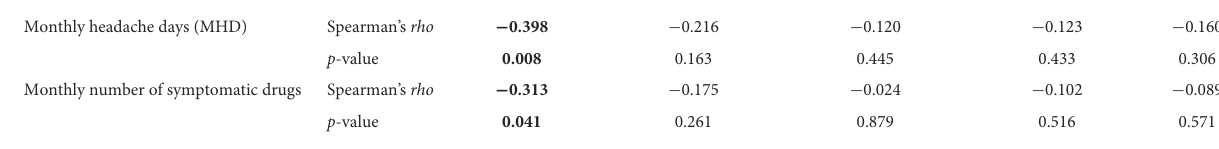
TABLE 4 Correlation between performances in the ToM battery and headache